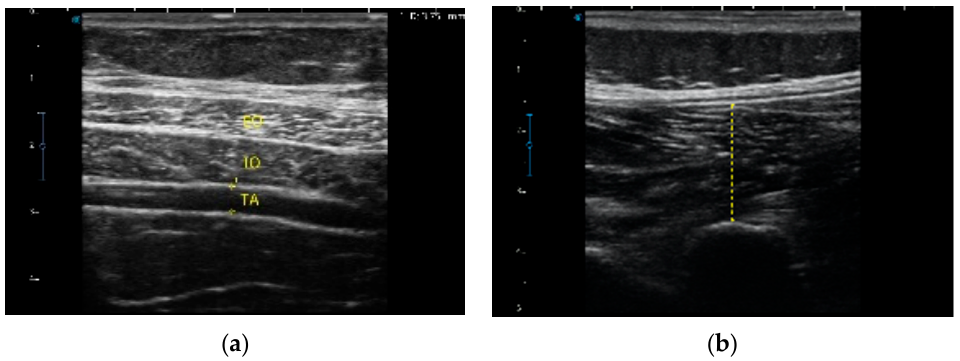
Figure 3. (a ) TA thickness measurement following a transverse section of the abdominal wall for observation of the External Oblique, Internal Oblique and TA. ( b ) LM thickness measurement following a longitudinal section of the paraspinal musculature between L4-L5 for observation of the LM.